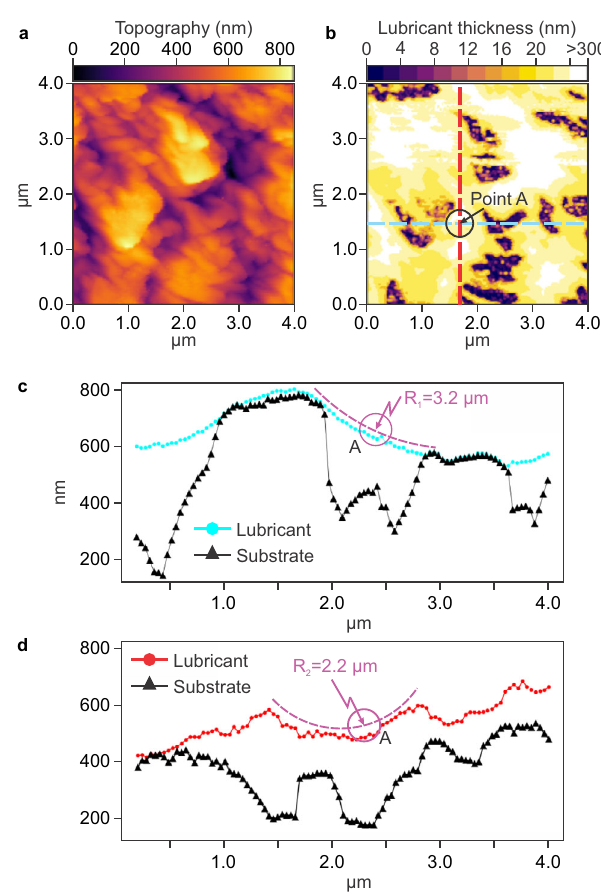
Fig. 2 Characterization of Te fl on wrinkles infused with silicone oil (10 cSt) using meniscus force atomic force microscopy. a Topographical map of an infused Te fl on-nanowrinkled surface in air. b Silicone oil thickness distribution on the surface after shearing at a fl ow rate of 600 μ L min − 1 for 30 min. The color scale is not linear: darker color represents regions with a lubricant fi lm less than 10-nm thick, white regions a lubricant thickness of more than 300 nm. c Pro fi le of the cross-section corresponding to the horizontal blue line in panel ( b ), and ( d ) pro fi le of the vertical red line in panel ( b ). R 1 and R 2 are the principal radii of curvature at point A. Source data are provided as a Source Data fi h o = 330 ± 230 nm. The solid fraction ϕ s exposed (regions with lubricant thickness lower than 10 nm) on the Te fl on wrinkles was